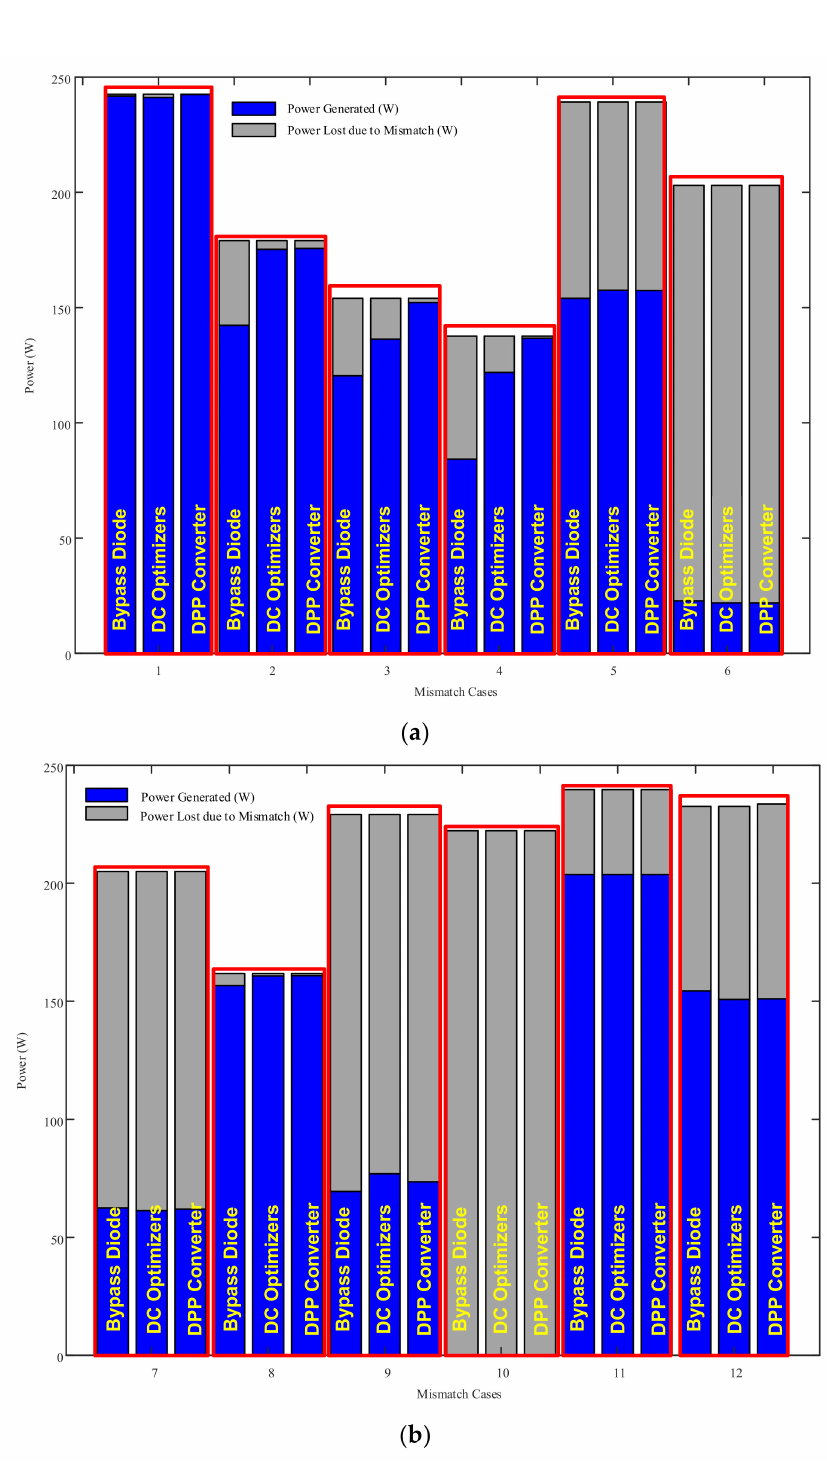
Figure 12. Power generated and lost under mismatch cases: ( a ) Cases 1–6 and ( b ) Cases 7–10. The voltage across the terminals T 1 , T 2 , and T 3 are given in Tables 3–5 for bypass diode, DC optimizer, and DPP converter, respectively. These tables show the results from Scenarios 5, 9, 10, 11, and 12, where the voltage stresses are much more severe across the shaded PV cell(s). Under these mismatched scenarios, the voltage across the individual cells is analyzed, which gives the voltage distribution among the cells within a PV sub- module. In Tables 3–5, the voltages V T1 , V T2 , and V T3 are the voltages at the terminals of the sub-modules, T 1 , T 2 , and T 3 , respectively. Similarly, V nscells , are the voltage across the non-shaded cells in a sub-module, while V scell is the voltage across the shaded cell(s)